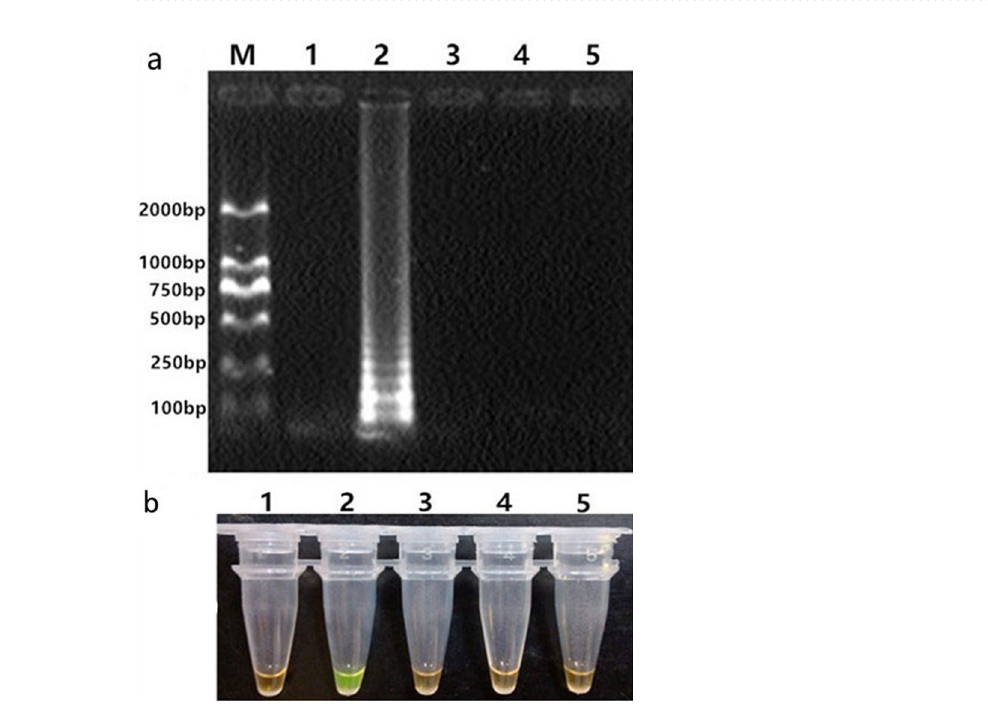
Figure 5. Specificity of the LAMP assay for SVBV. Detection of LAMP products by ( a ) agarose gel electrophoresis and ( b ) visual inspection by SYBR green I. Lane M, DL2000 DNA Marker; lane 1, Negative control; lane 2–5, Samples with DNAs/cDNAs of Strawberry vein banding virus (SVBV), Strawberry mottle virus (SMoV), Strawberry mild yellow edge virus (SMYEV) and Strawberry crinkle virus (SCV). The full-length gels are presented in Supplementary Fig.